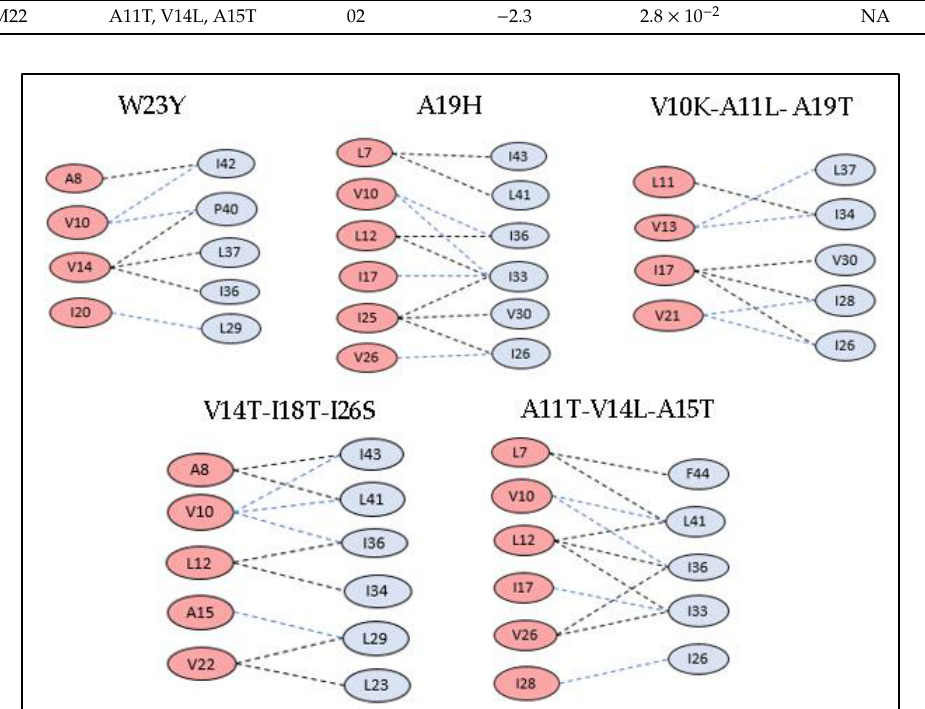
Figure 7. The hydrophobic interactions within 5 Å for Vpu mutants having reduced binding affinities and minimal hydrophobic connections.